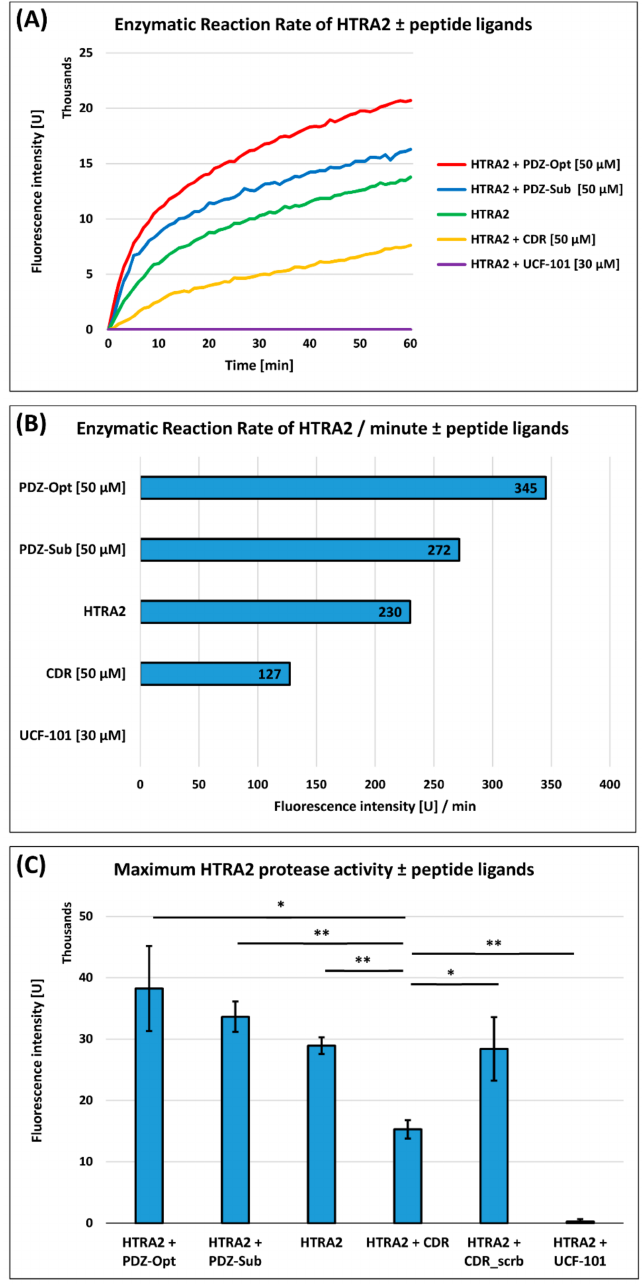
Figure 1. Determination of the HTRA2 protease activity using the fluorescent H2 optimal substrate. Enzymatic cleavage of the H2 optimal substrate elicited fluorescence emission at 405 nm, which is correlated with the proteolytic activity of HTRA2. ( A ) Enzymatic reaction rates of HTRA2 ± PDZ domain-binding peptide ligands PDZ-Opt (50 µ M), PDZ-Sub (50 µ M), and the synthetic CDR peptide (50 µ M). In addition, HTRA2 was treated with the specific protease inhibitor UCF-101 (30 µ M). ( B ) This graphic illustrates the enzymatic reaction rates of HTRA2 per time units (minutes). Average degradation rates (U/min) of the H2 optimum substrate are shown for the groups HTRA2 ± PDZ-Opt (50 µ M), PDZ-Sub (50 µ M), the synthetic CDR peptide (50 µ M), and UCF-101 (30 µ M). ( C ) Maximum degradation rates of the H2 optimum substrate by HTRA2 at 37 ◦ C for 1 h. HTRA2 was treated with the PDZ domain-binding peptide ligands PDZ-Opt (50 µ M), PDZ-Sub (50 µ M), the synthetic CDR peptide (50 µ M), and UCF-101 (30 µ M) ( n = 3 for all groups). In addition, HTRA2 was treated with a scrambled CDR peptide analog (50 µ M; n = 3). **: p < 0.01, *: p <